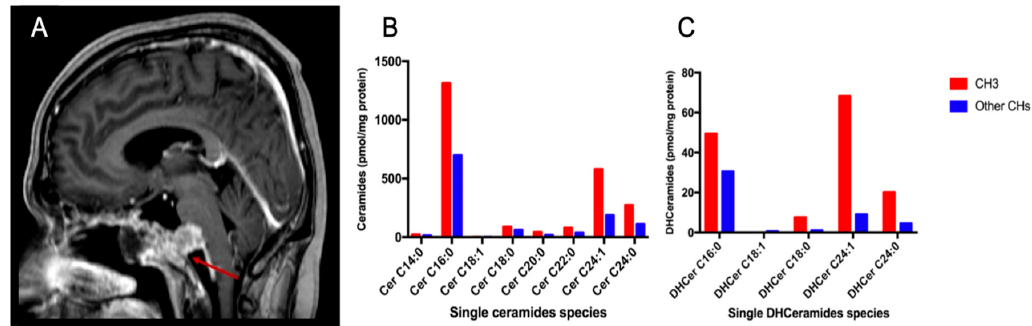
Figure 8. Exemplificative case of a SBC with an aggressive behavior. Sagittal ( A ) T1-weighted post-contrast MR image showing a chordoma (red arrows) with an intense contrast enhancement. Pathology showed a de-di ff erentiated chordoma with a high rate of MIB-1 staining (20%). Sphingolipid analysis showed the highest content in ceramides ( B ) and dihydroceramides ( C ). Bar graphs showing the ceramide content of the present case (red) in comparison with the average of ceramide levels of other chordoma patients (blue).